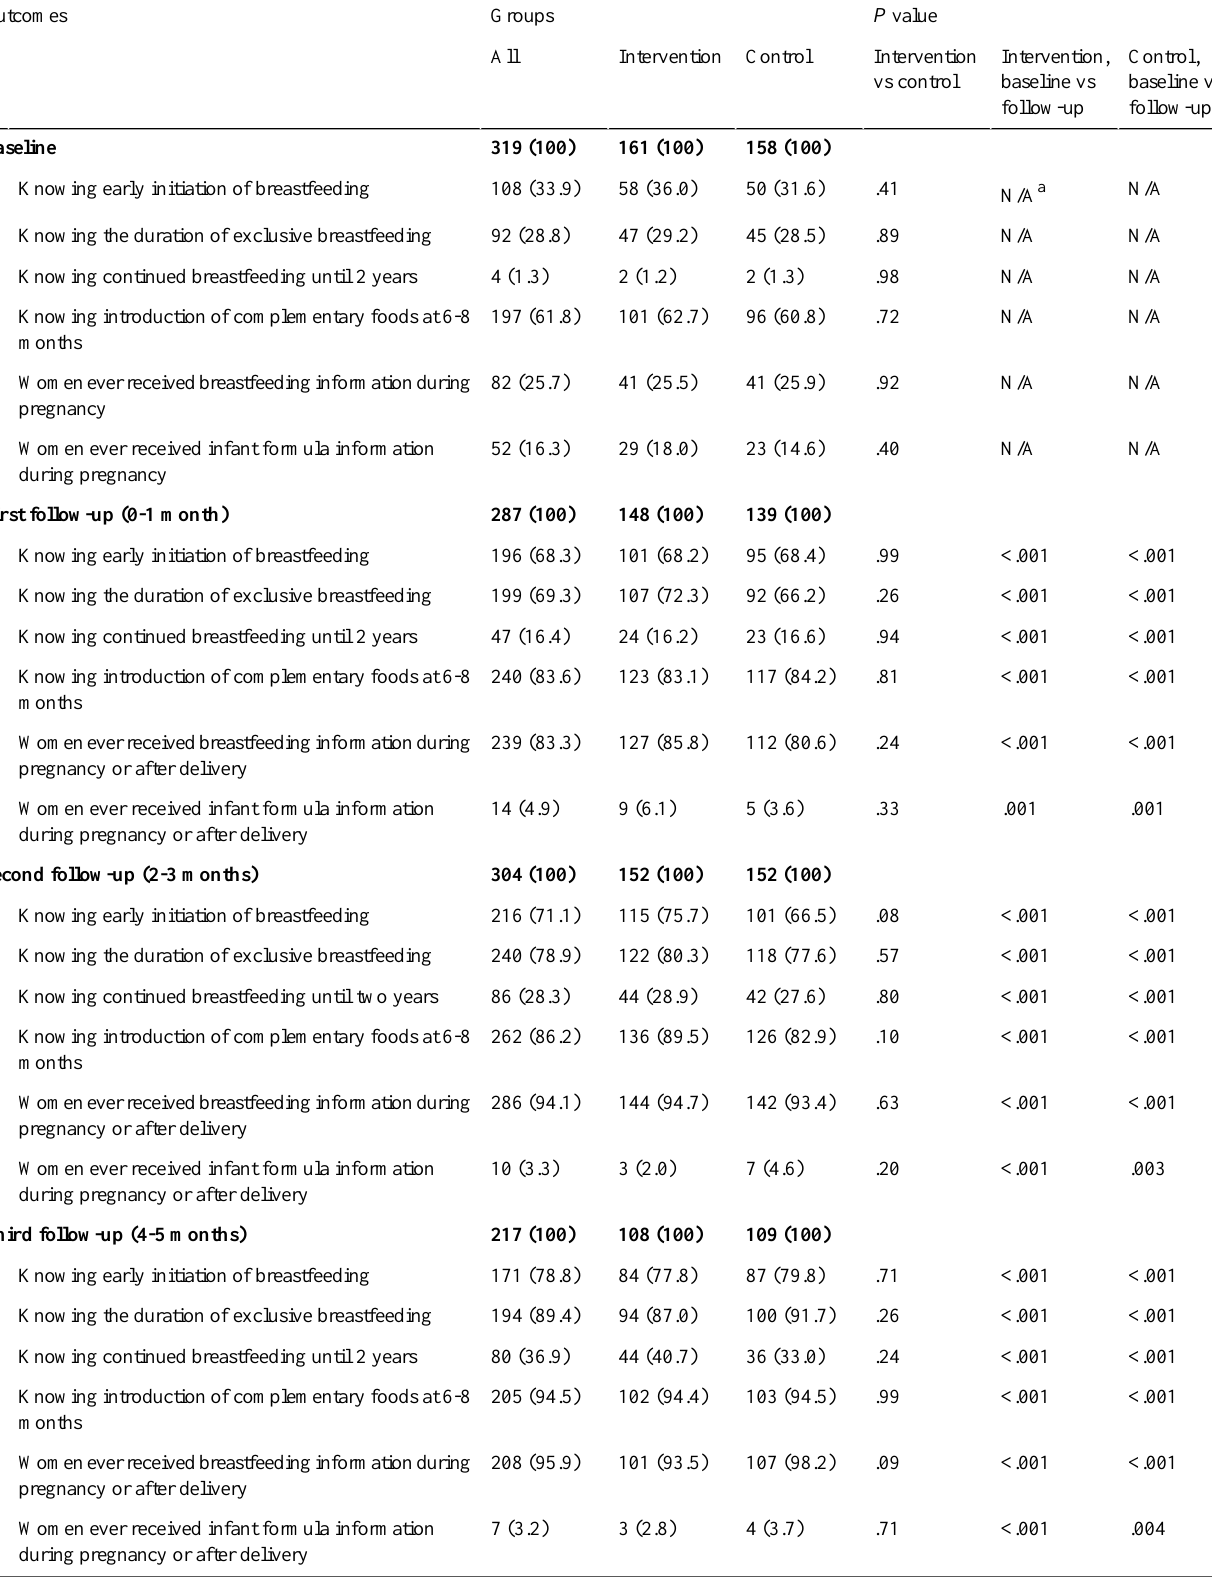
Table 3. Comparison of infant feeding knowledge between the intervention and control groups.